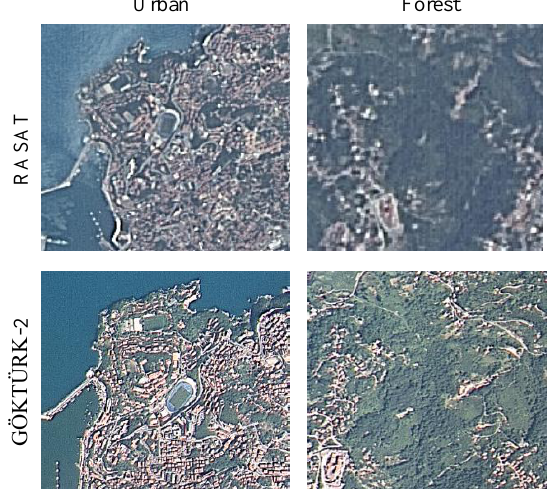
Figure 4. Viusal comparison in urban and forest